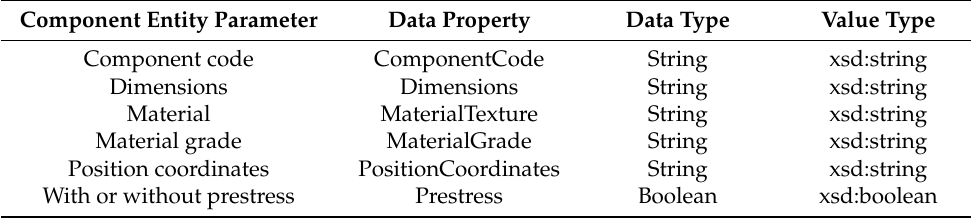
Table 2. Example of component entity information data property.